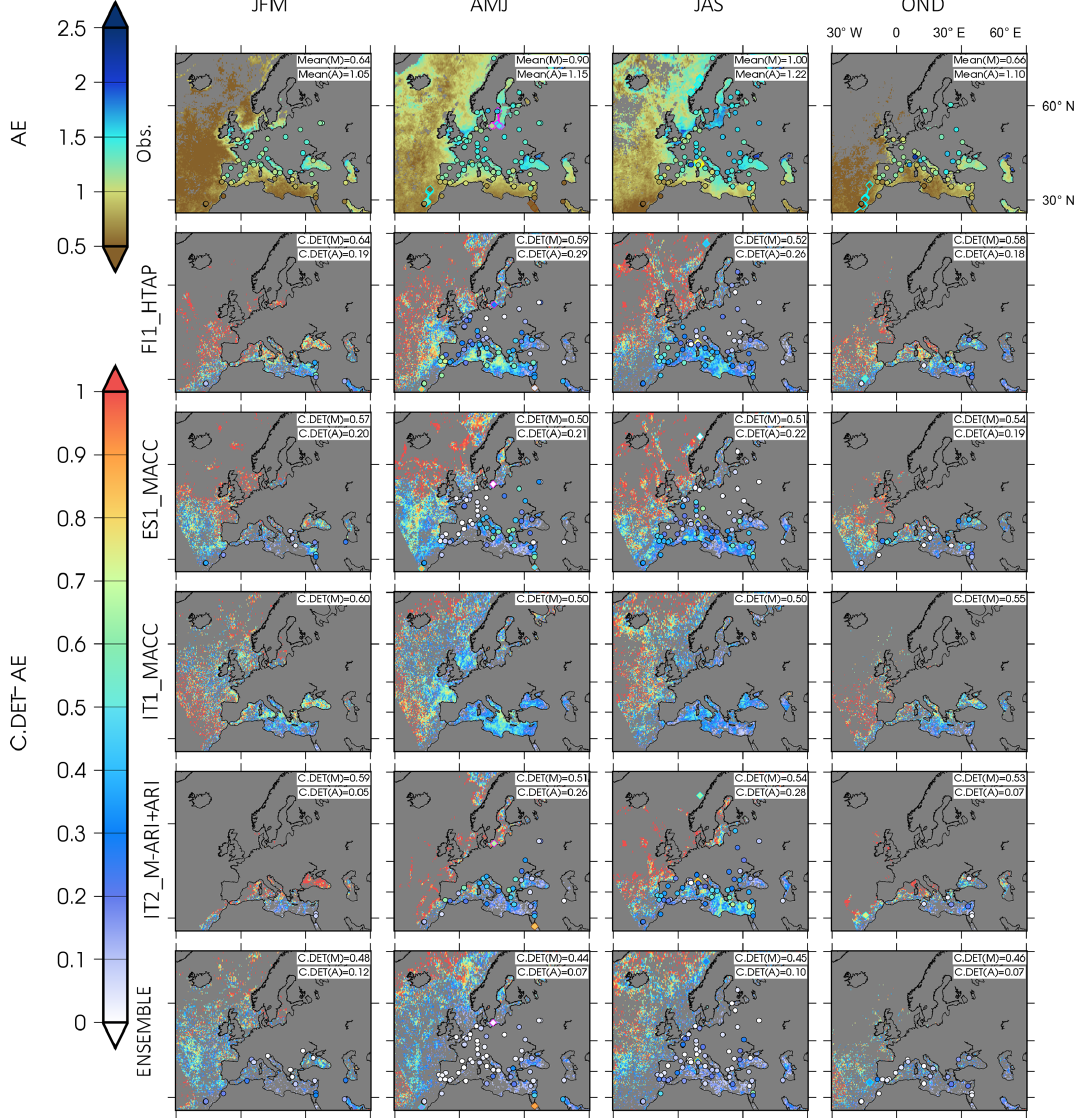
Figure 7. The same as Fig. 5 for the determination